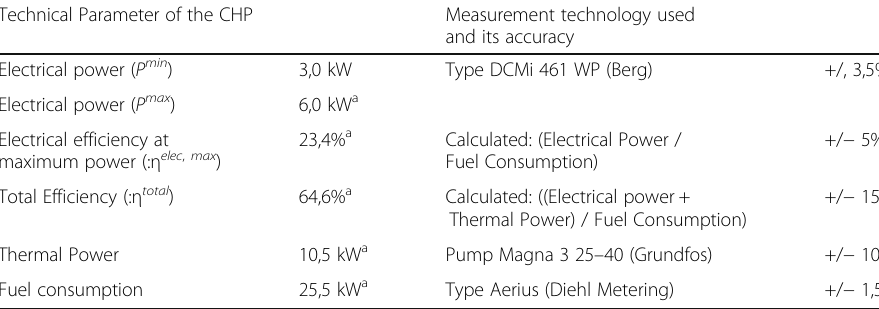
Table 2 Technical data of the cogeneration unit.